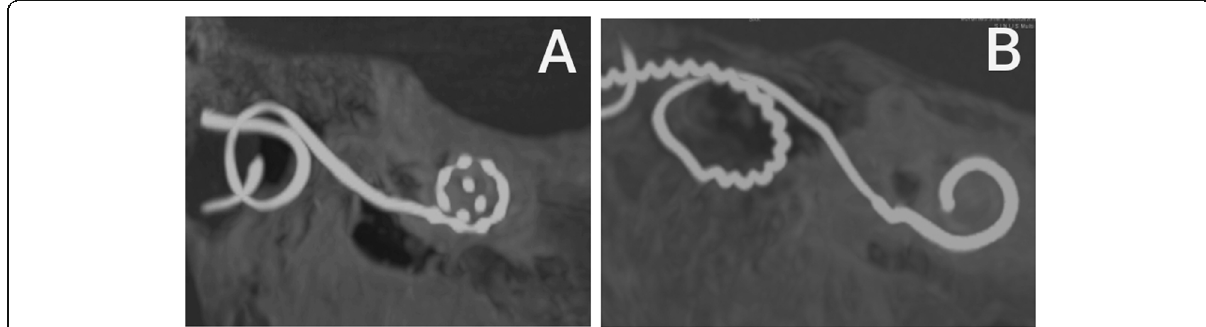
Fig. 5 Oblique coronal reconstruction CT images of two patients underwent CI through EAEA: a - right ear), showing a full insertion of the electrode array to apical turn in ST with a linear insertion depth of 30 mm and angular insertion depth of 680°. b - (right ear), showing a partial insertion to the end of middle turn of the electrode array in ST with a linear insertion depth of 22 mm and angular insertion depth of